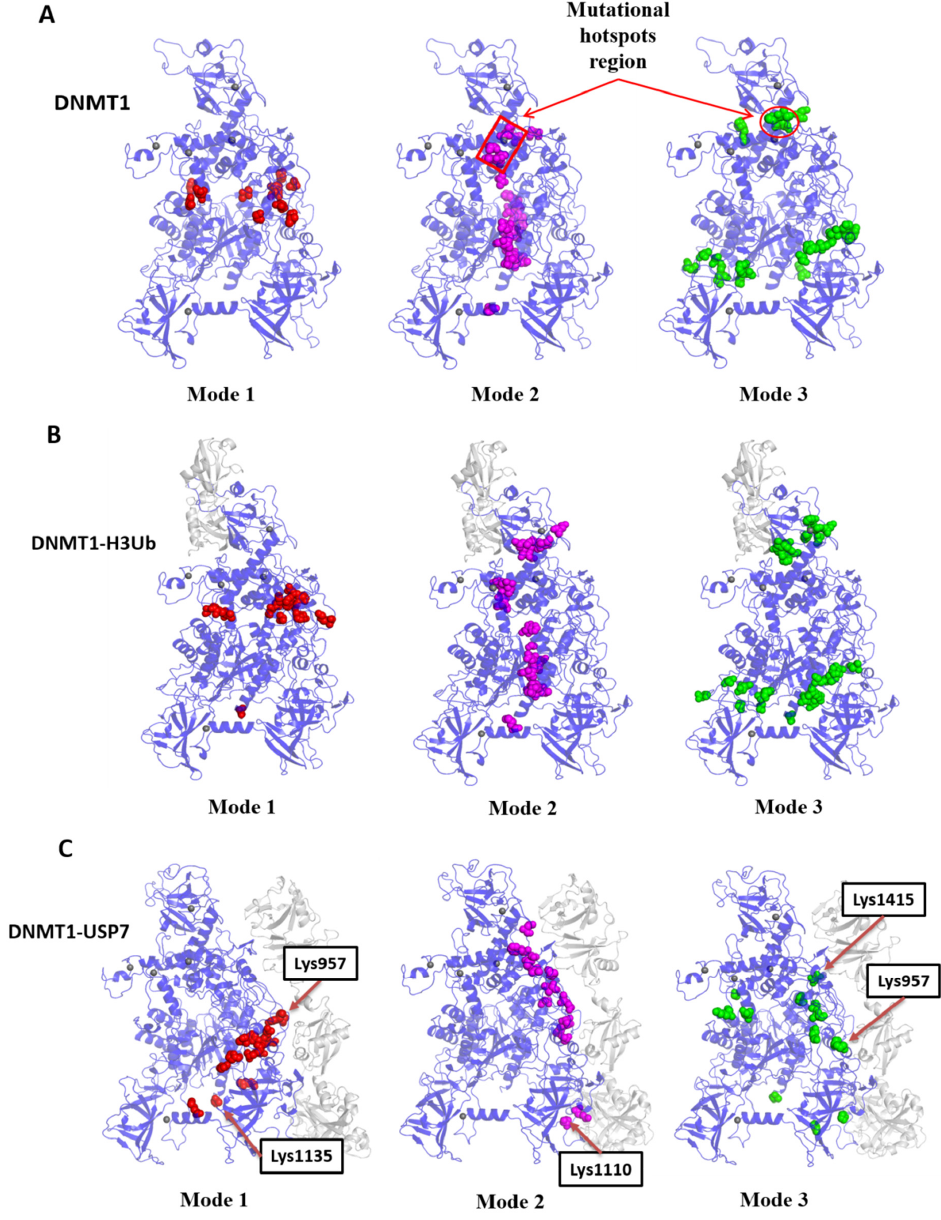
Figure 4. The prediction and structural mapping of hinge sites of ( A ) DNMT1, ( B ) DNMT1-H3Ub, and ( C ) DNMT1-USP7 based on their GNM modes 1, 2, and 3. The catching mutational and PTM sites are indicated by arrows.